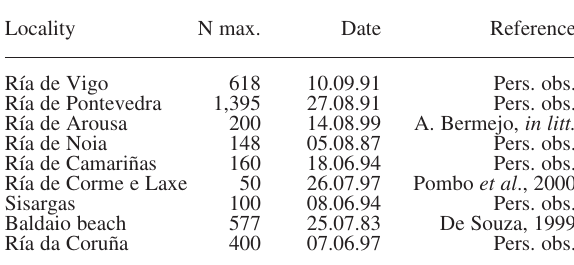
T ABLE 2. – Records of the largest number of Balearic shearwaters (Nmax) for sites where groups of birds have been observed along the Galician